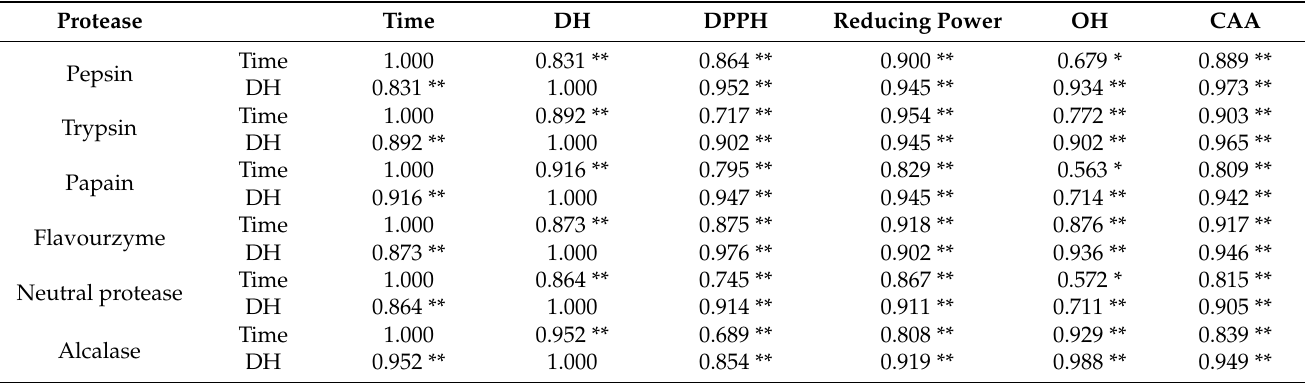
Table 1. Correlation between hydrolysis time, DH of Oviductus Ranae protein and antioxidant activity of enzymatic hydrolysates.